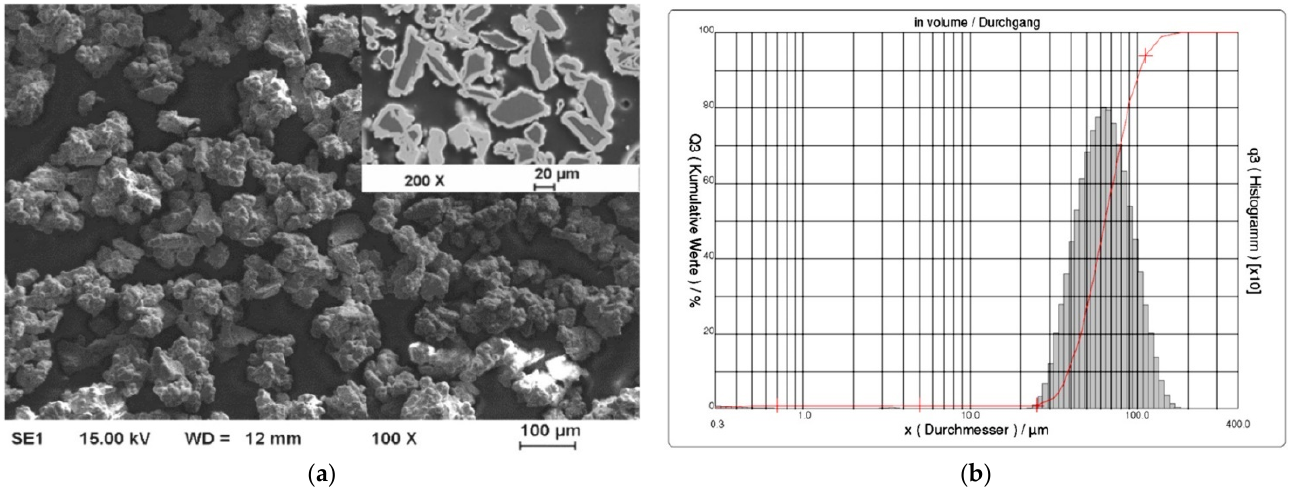
Figure 7. Nickel cladded alumina powder agglomerates fabricated by hydrothermal hydrogen reduction: SEM (SE) micrograph of powder ( a ) and particles’ size distribution ( b ) Reprinted with permission from [68]. Copyright 2021 Elsevier.